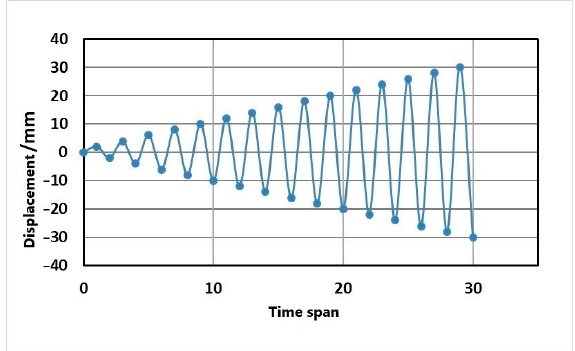
Figure 13. Cyclic loading